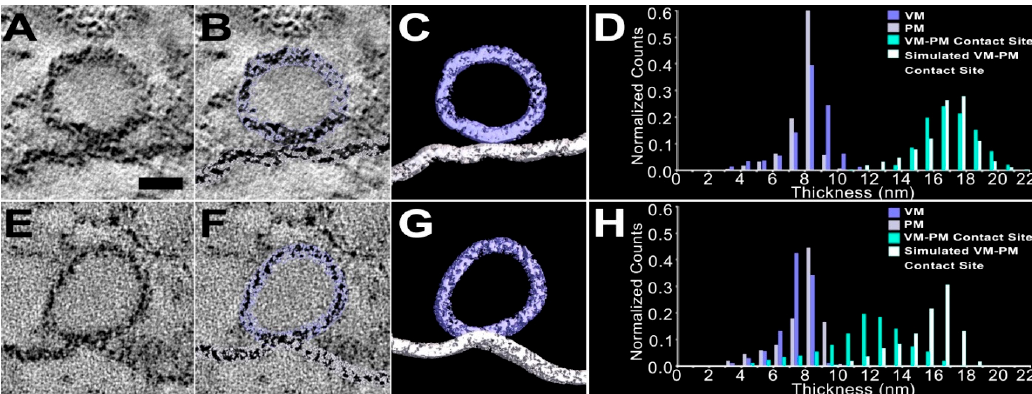
Figure 2. Vesicle membrane–presynaptic membrane (VM–PM) contact sites of two docked synaptic vesicles on the presynaptic membrane, at two different active zones and measured membrane thicknesses. ( A , E ) Virtual slices (0.5 nm thick) of the two docked synaptic vesicles on their presynaptic membranes at active zones of the frog NMJs. Scale bar = 25 nm. ( B , F ) Surface models of the two docked synaptic vesicles (light blue) and the stretch of presynaptic membranes (light gray) are superimposed on the two virtual slices. ( C , G ) Portions of the models (10 nm thick) of the vesicles and presynaptic membranes are visualized. The vertices used to generate the models provide continuous surfaces for the vesicle membrane and presynaptic membrane, while accounting for irregularities in the membrane staining. ( D , H ) Frequency distributions of thousands of vertex-to-vertex thickness measurements made across the entire membranes of the two docked synaptic vesicles and the presynaptic membranes, from their 3D surface models. For the docked synaptic vesicle in A – C , the membrane thicknesses of the individual membranes away from their contact sites are 8.3 nm ± 1.5 nm (mean ± SD) for the VM and 8.1 nm ± 1.1 nm (mean ± SD) for the PM, and the combined thickness of the vesicle membrane and presynaptic membrane at the contact site (16.4 nm ± 1.5 nm; mean ± SD) is not different from the expected combined thickness (16.5 nm ± 1.9 nm; mean ± SD) obtained by summing randomly the vesicle membrane and presynaptic membrane thicknesses away from the contact site (Bootstrap test, p = 0.97; See Materials and Methods). For the docked synaptic vesicle in E – G , the VM and the PM are 7.5 nm ± 1.0 nm and 7.8 nm ± 1.5 nm, respectively. The combined thickness of the vesicle membrane and presynaptic membrane at the contact site (11.6 nm ± 2.4 nm; mean ± SD) is less than its expected combined thickness (Bootstrap test, p < 0.05), showing that the docked vesicle is merged with the presynaptic membrane. Note that each membrane varies in thickness from one vertex to another, mainly due to irregular staining of the